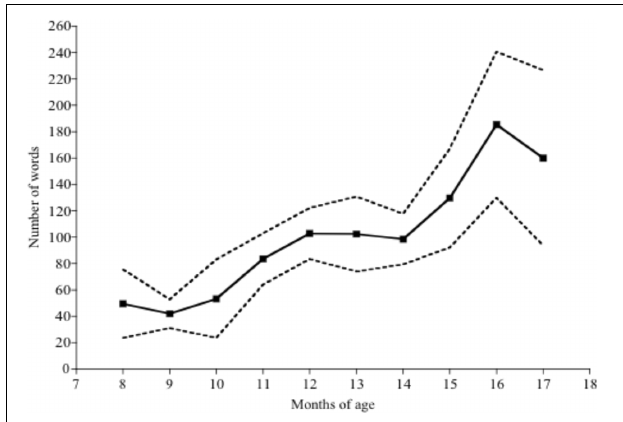
FIGURE 2 | - Number of words comprehended by children of each age, with 95% confidence intervals.